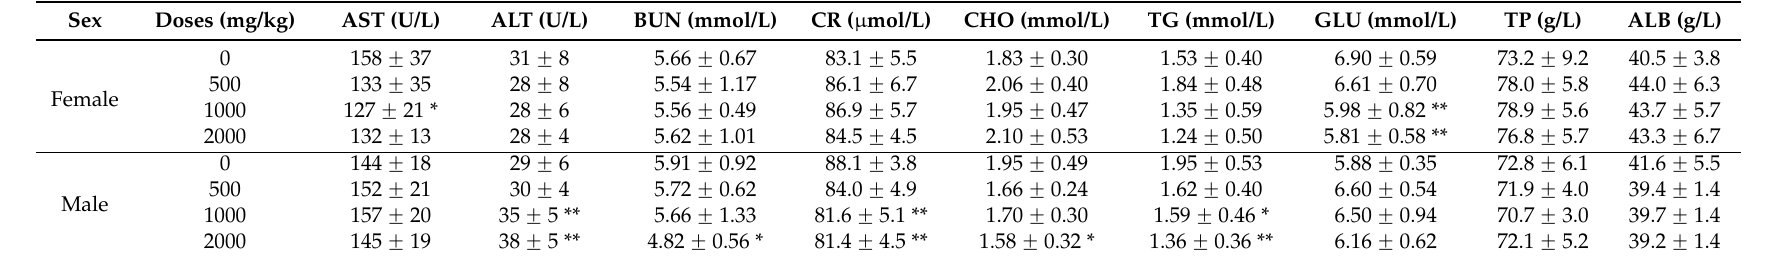
Table 8. Effects of GBP on serum biochemical indexes in rats (x ˘ s).